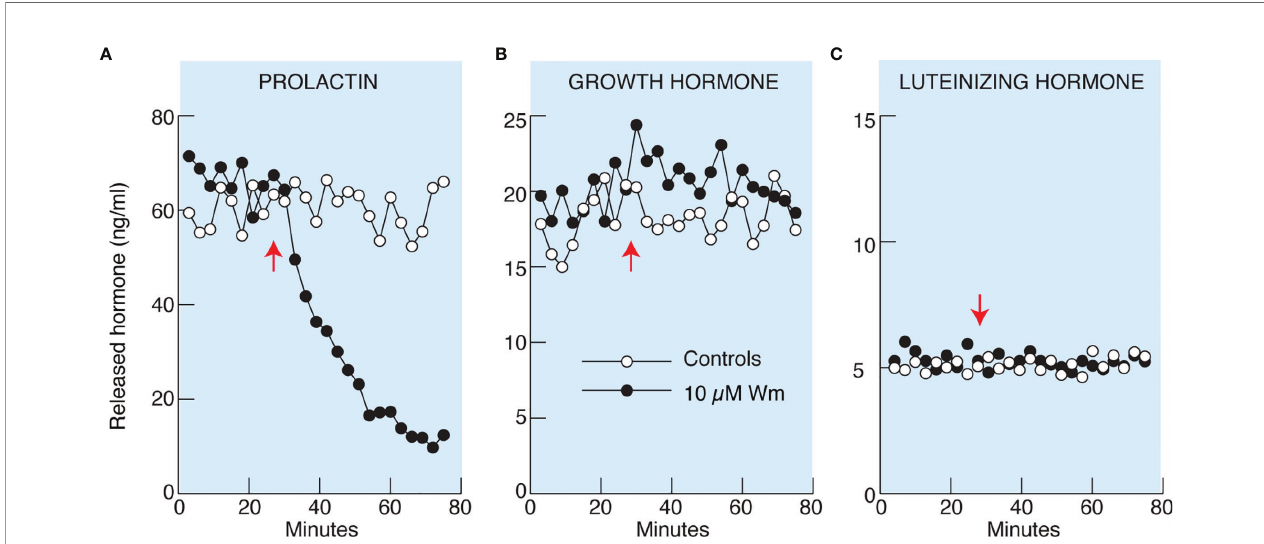
FIGURE 2 | Wortmannin (Wm) inhibited basal prolactin (A) , but not growth hormone (B) and luteinizing hormone (C) , secretion in perfused rat anterior pituitary cells. Freshly dispersed pituitary cells were attached to beads and cultured for 20 hours before the experiments. Perfusion was performed in 0.5 ml volume chambers at a fl ow rate of 0.5 ml/min and the cells were washed for 2 hours before collecting samples. After the wash period, samples were collected every three minutes for 76 minutes. Vertical arrows indicate the time of application of 10 µM Wm (black circles) or solvent (white circles). Hormone content of the ef fl uent was measured by ELISA. Data shown are representative from three (A) and two (B, C) similar experiments. For 10 µM Wm-induced inhibition of basal PRL release see also Figures 4C , 5B , C , 7C , D , 8B , and 9D